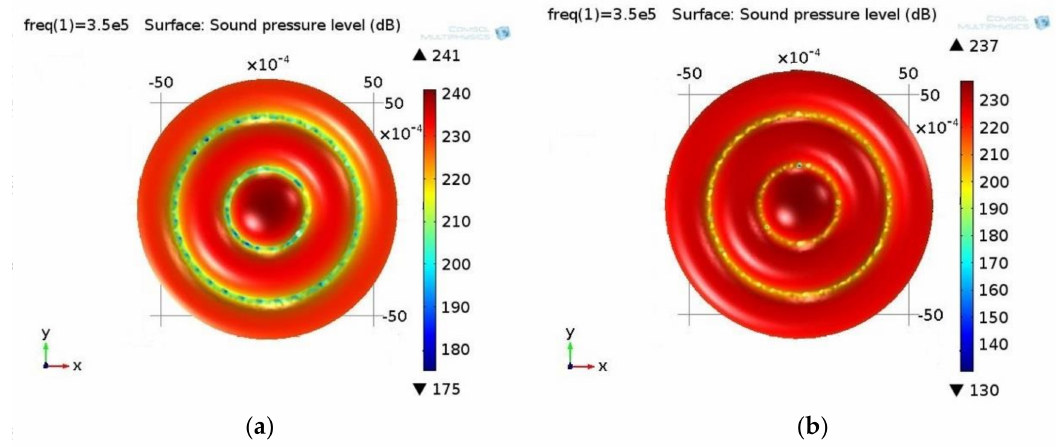
Figure 3. Sound pressure level (dB) in ( a ) biological and ( b ) water suspension. Excitation frequency: 350 kHz. The sound pressure field is analogous in both fluids, i.e., there are three high pressure